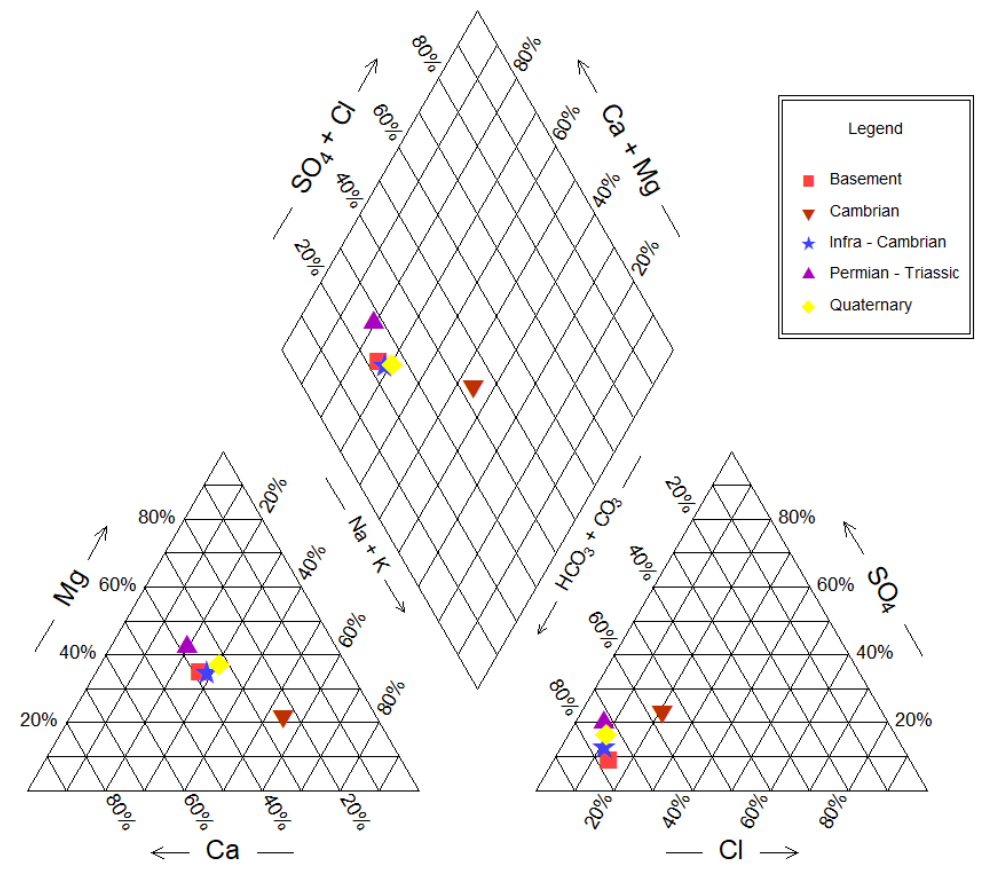
Figure 3. Piper diagram showing the study area’s groundwater type.